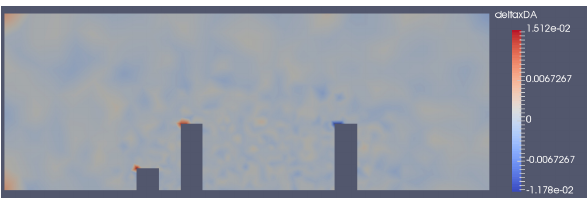
Fig. 11 Results of the VarDA algorithm with (cid:28)(cid:28)(cid:28) =295 EOFs for Velocity field.